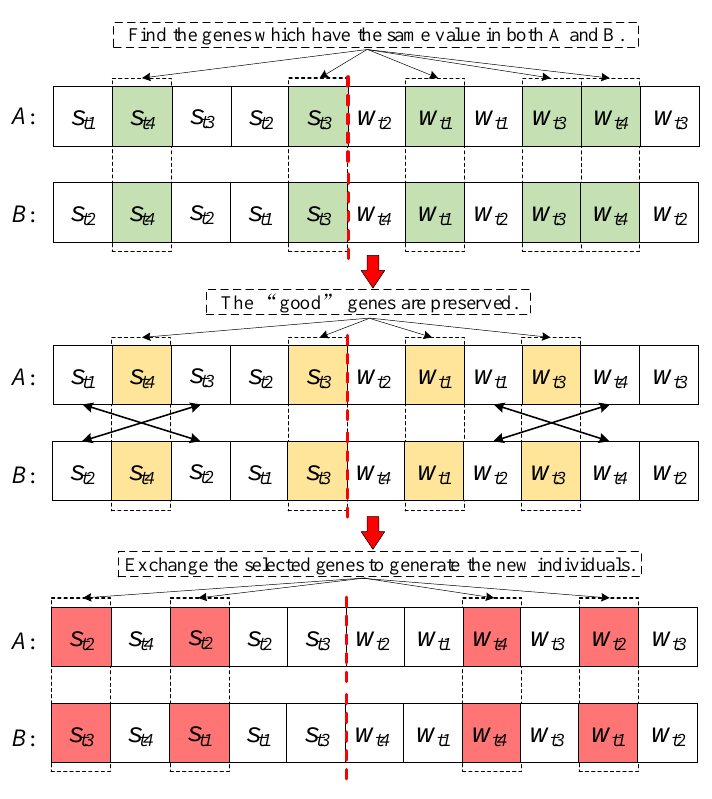
Figure 7. The illustration of the improved EX